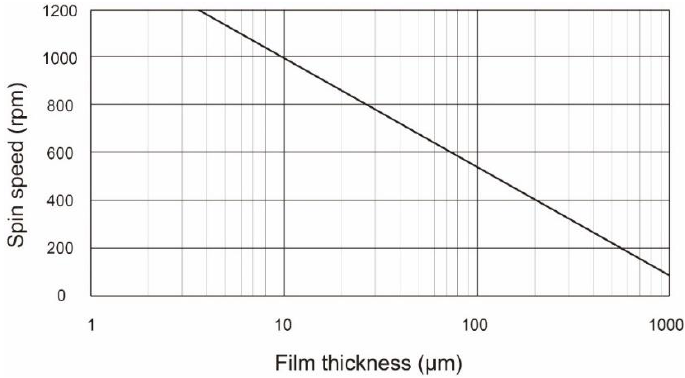
Figure 2. The relationship between spinning speed and film thickness was obtained based on a power